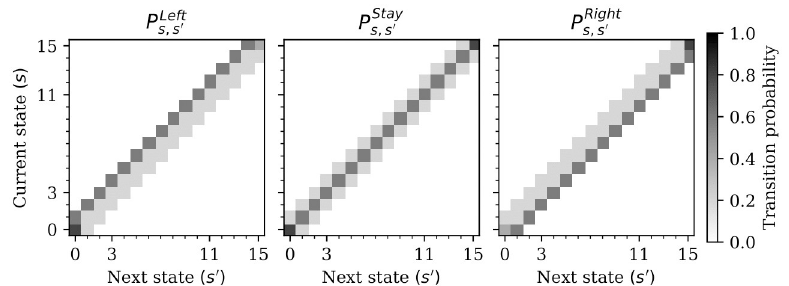
Fig 4. Markov stag-hunt transition probabilities of an individual agent. Darker colors indicate higher probability. Shown are 5 different colors, which, from lightest to darkest, have probabilities of 0% (white), 20%, 40% (corners), 60%, and 80% (corners). Black does not appear because there are no degenerate transitions which would make agents get stuck. Each agent chooses one of three actions (Left, Stay, or Right) and, depending on their current state, move to another state according to the respective transition probabilities. The state of an agent does not change the transition probabilities of the other agent, e.g. an agent cannot block the other agent.